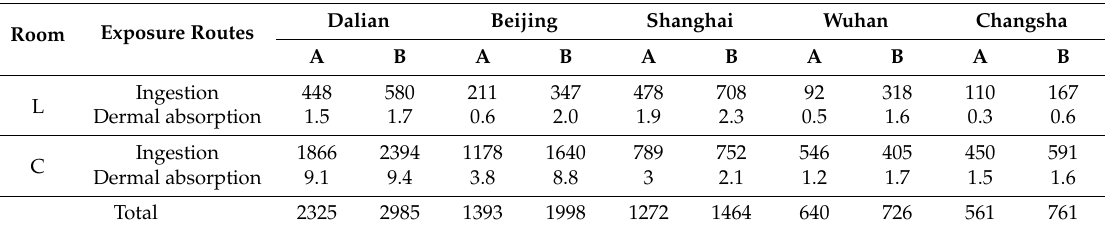
Table 5. Child’s daily exposure to DBP and DEHP in the investigated households in winter